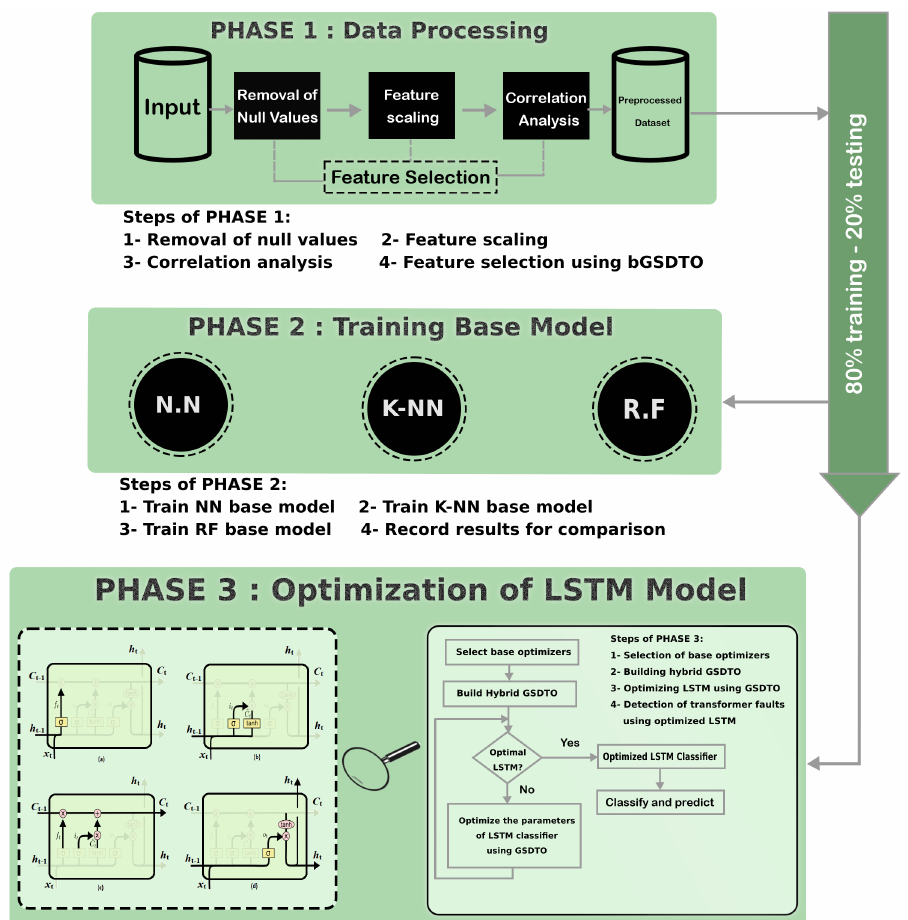
Figure 3. Proposed feature selection and classification model based on the proposed GSDTO algo-